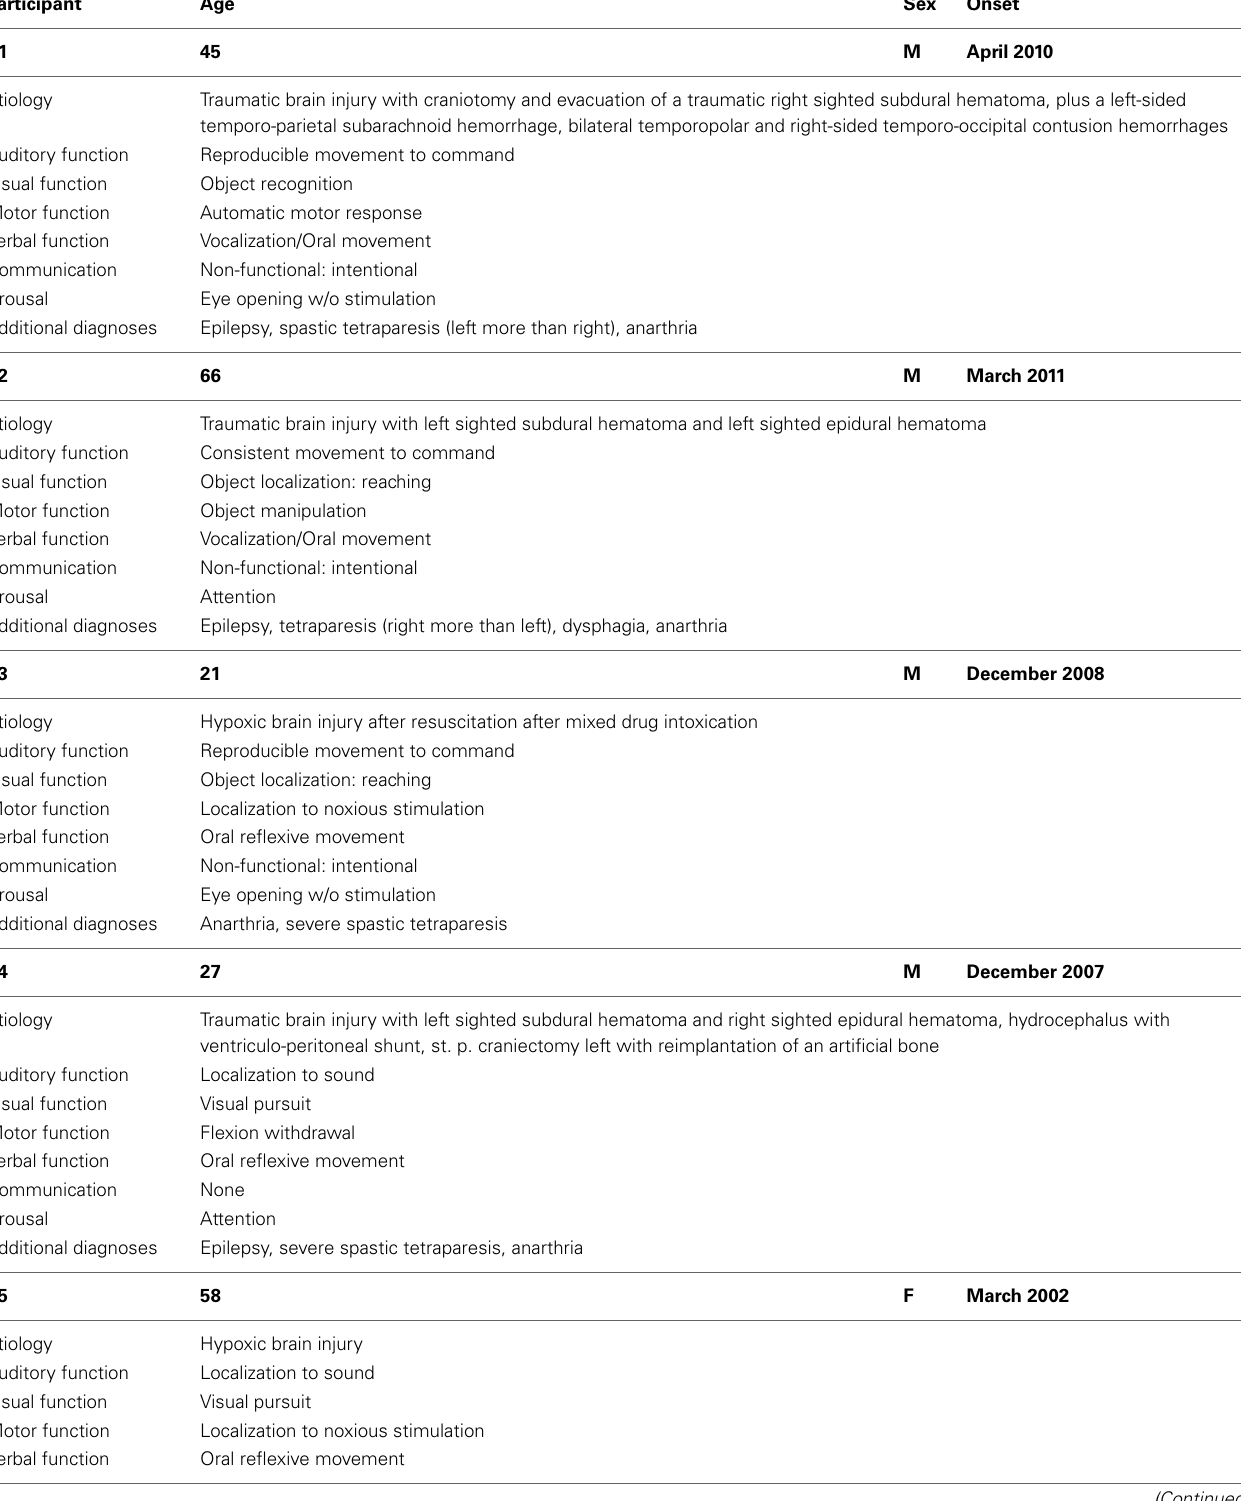
Table 1 | Overview about participants for both the command following and the online feedback paradigm.